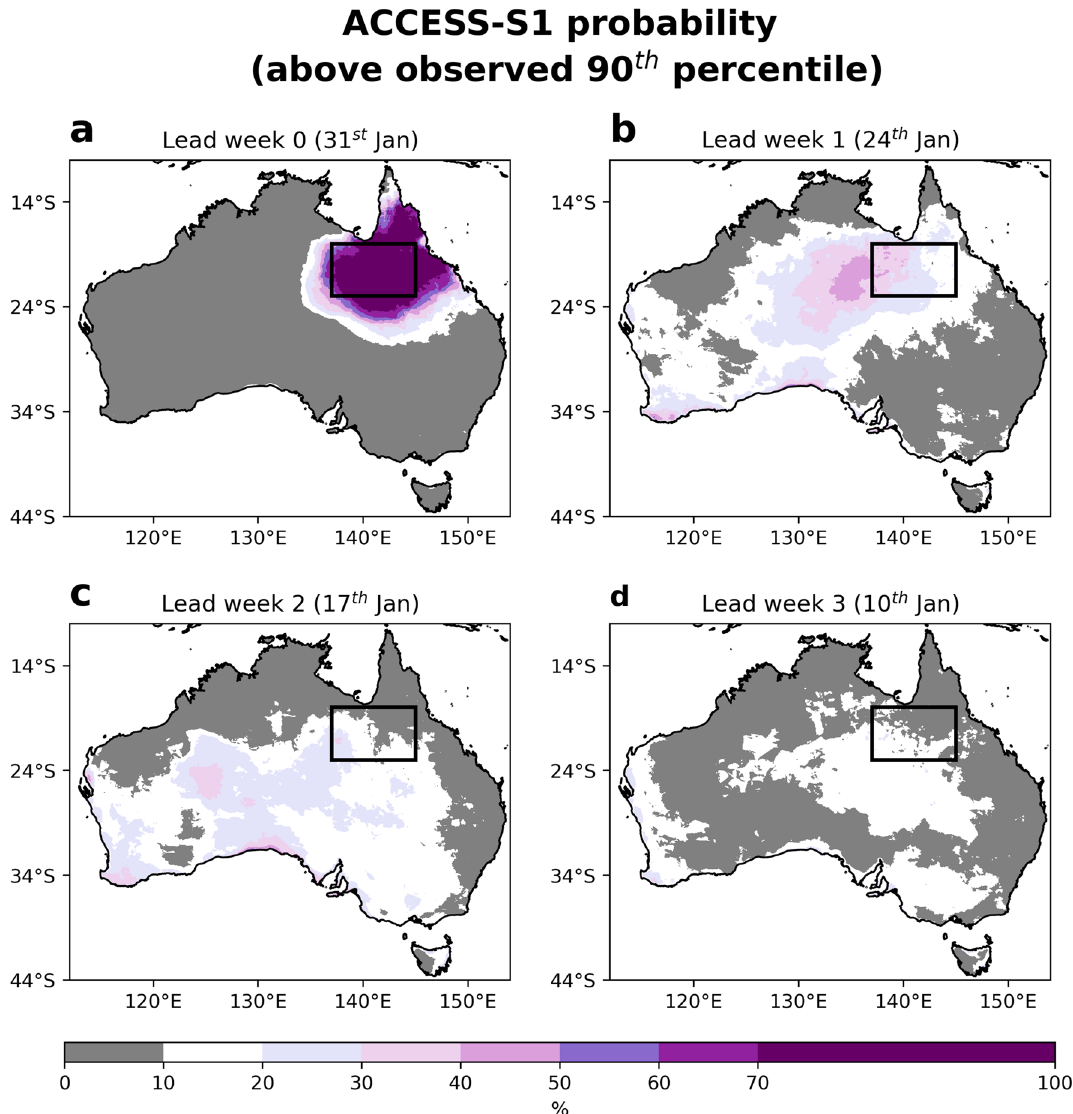
Figure 3. Lead week 0–3 forecasts of the chance of extreme livestock chill conditions during the February 2019 floods from ACCESS-S1. Shown are the ACCESS-S1 forecasts of the livestock chill index being above the observed multi-year (1971–2018) daily 90th percentile, targeted to the week of 31 January– 6 February, for ( a ) lead week 0; 31 January, ( b ) lead week 1; 24 January, ( c ) lead week 2; 17 January and ( d ) lead week 3; 17 January. The Gulf region is shown by the black